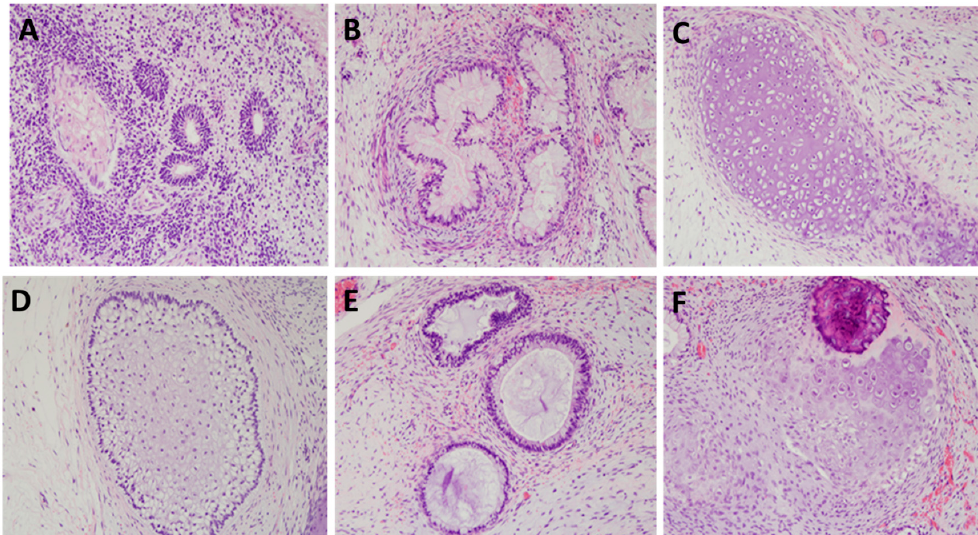
Figure 10. Teratoma assay. H9 hESC cultured in homemade E8 media containing either hFGF-2 or hDJ-1 were injected into NOD or NOD/SCID mice. After 12 weeks, teratomas were formed in both groups. Hematoxylin and eosin stains of teratoma microsections revealed robust differentiation into all three germ layers in the hFGF-2 group ( A – C ) and hDJ-1 group ( D – F ). (A) Neuroepithelium (ectoderm), (B) cartilage (mesoderm), (C) glandular tissue (endoderm), (D) squamous epithelium (ectoderm), (E) cartilage (mesoderm), and (F) glandular tissue (endoderm) lineages.